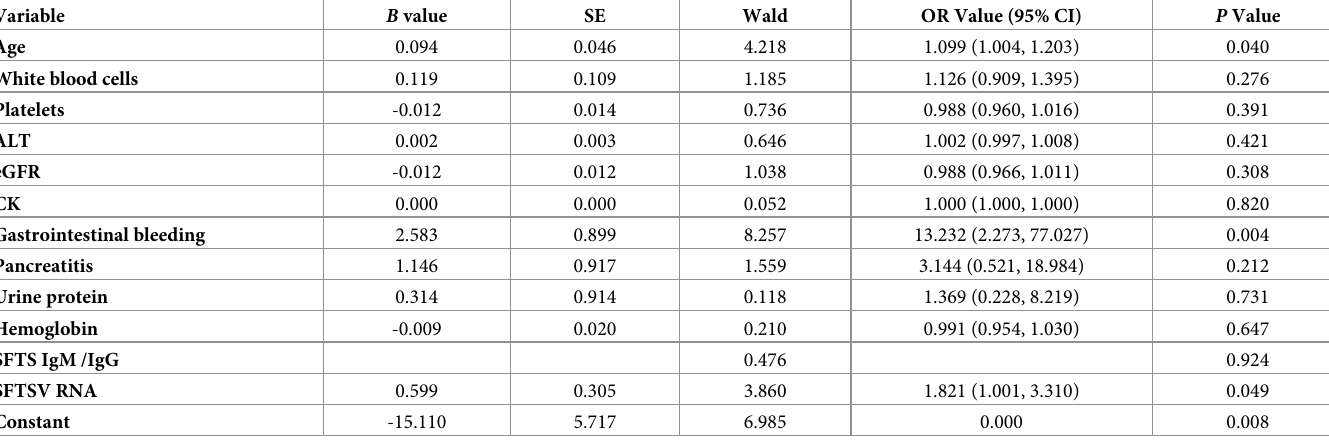
Table 2. Multivariate Logistic Analysis of Factors Affecting the Prognosis of Patients with SFTS in the Modeling Group.